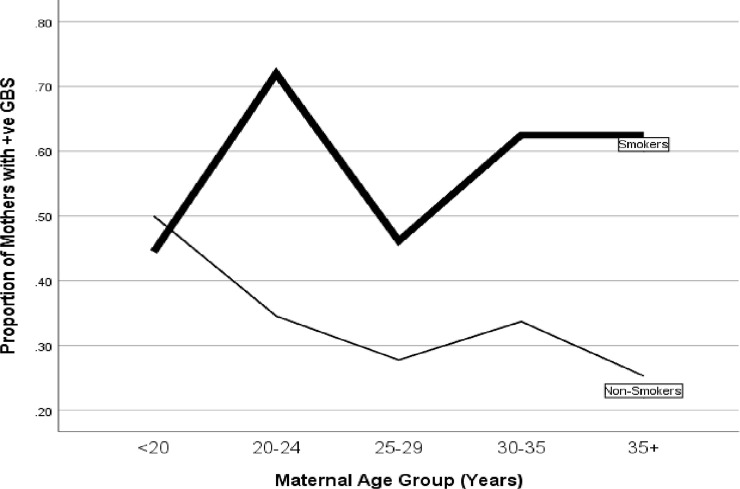
Prevalence of maternal GBS colonization by maternal age group and smoking status.This Figure shows that, for smoking mothers, there was no relationship between maternal age and GBS colonization (P of Trend = 0.935) whereas for the non-smoking mothers there was a clear inverse-relationship between maternal age and GBS colonization (P of Trend <0.05).